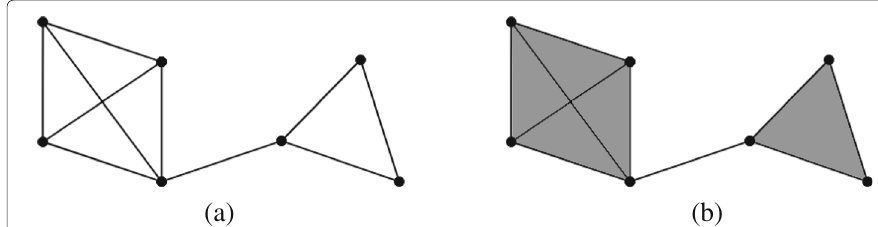
Fig. 3 An example for constructing the clique complex of a graph. a A graph G , b The clique complex CI ( G ) of the graph on the